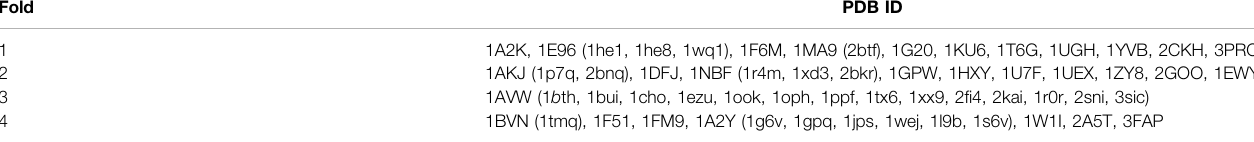
TABLE 1 | Dockground dataset splits for training and testing GNN. Fold PDB